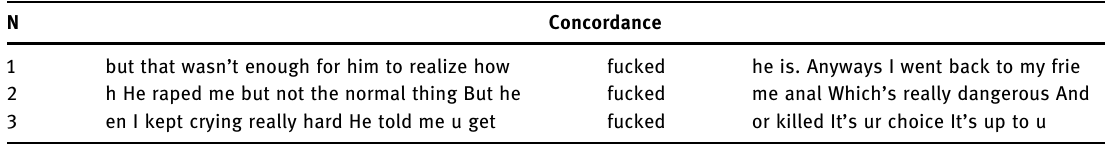
Table 34: Concordance lines for fucked N